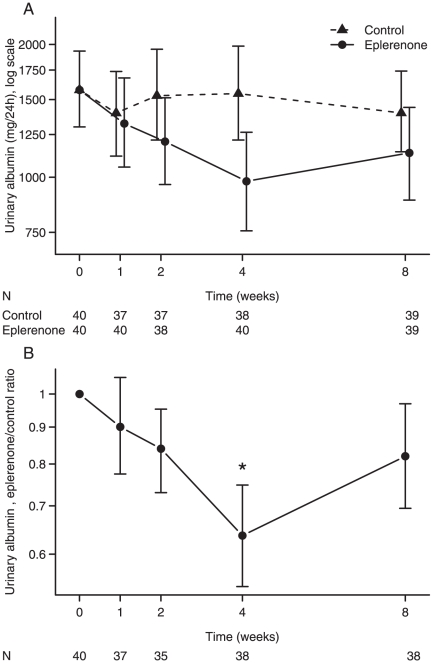
Urinary albumin excretion.
Figure 1A illustrates albumin excretion during 8 weeks of add-on eplerenone as compared with control. Figure 1B illustrates the difference in urinary albumin excretion between treatment with eplerenone and control. Data are presented as mean values with 95% CI of the mean values. * P<0.05 for U-albumin excretion in the eplerenone period versus control period after Bonferroni correction. The difference in U-albumin excretion at week 4 versus week 8 in the eplerenone period was not significant. Note: N = number of urine samples.